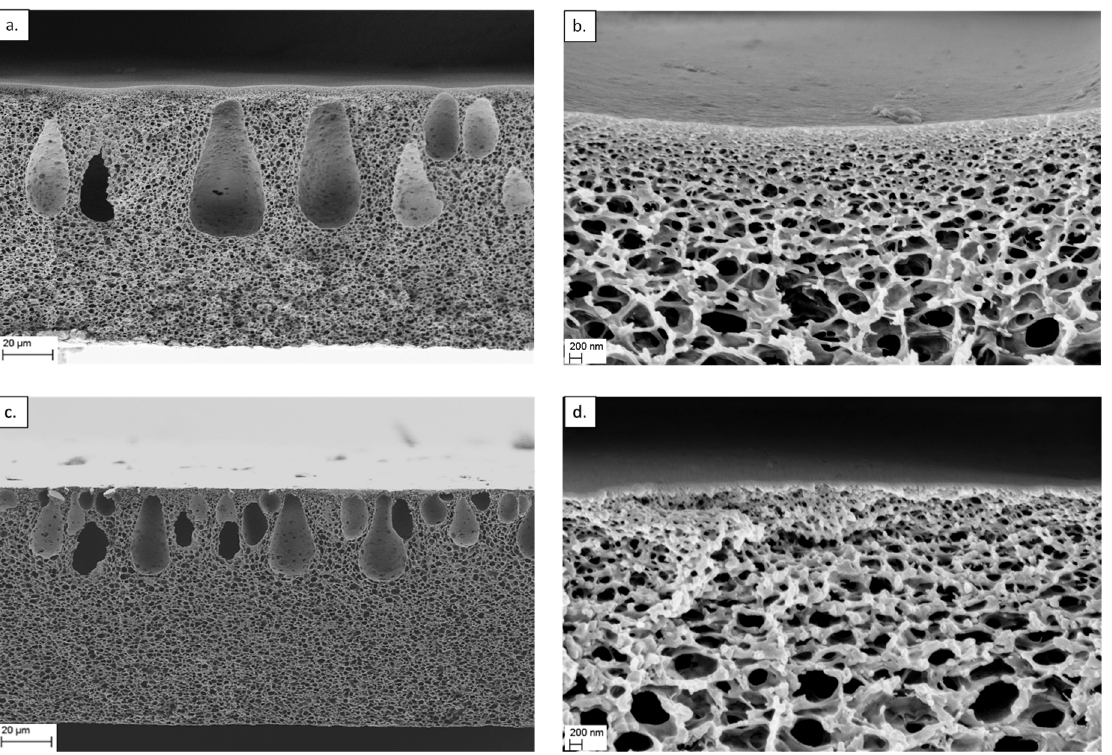
Figure 7. SEM of the cross-section of CA nanocomposites with 0.001% ( a , b ) Eli-0 and ( c , d ) Eli-400 CNTs at two different magnifications.